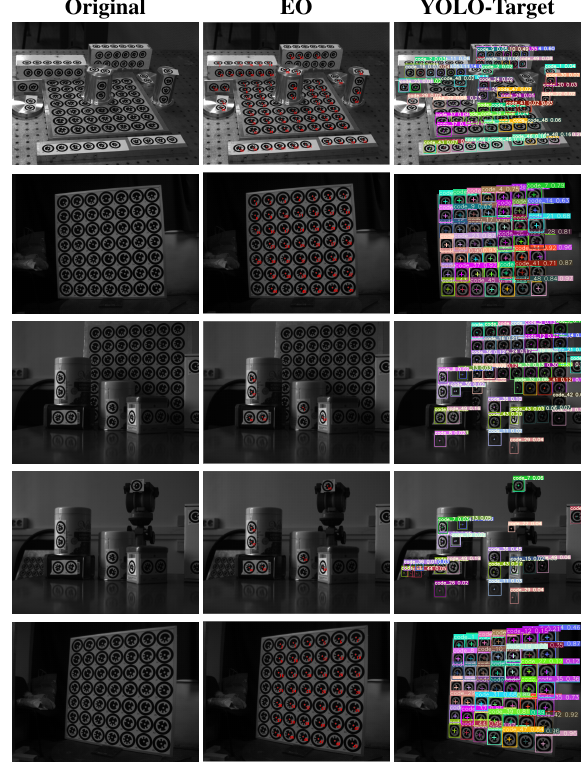
Figure 6. Detection